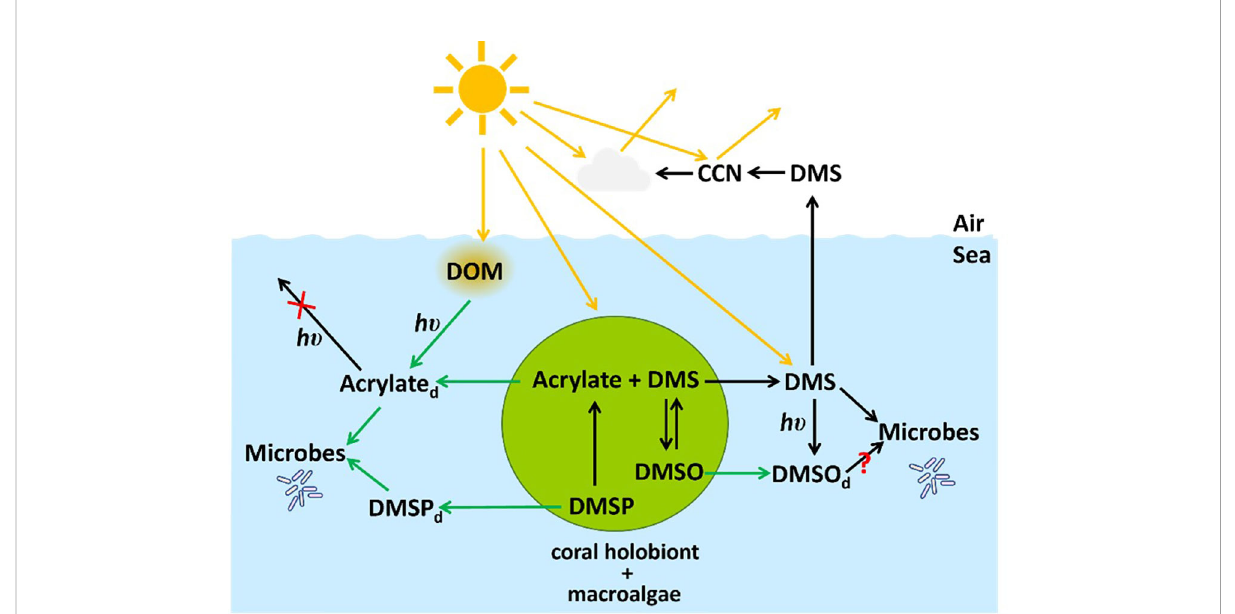
FIGURE 11 A simpli fi ed view of the marine organosulfur cycle (1) showing the link between the marine cycle and the atmosphere through DMS and the production of cloud condensation nuclei (CCN), and (2) depicting the main fi ndings of our study highlighted by green arrows. Dissolved acrylate is photochemically produced from the interaction of sunlight ( h υ ) with dissolved organic matter (DOM), and macroalgae and the coral holobiont release acrylate and DMSP into the dissolved phase where they are rapidly consumed by microbes in the Mo ’ orea coral reef. Acrylate does not photolyze in seawater at ambient concentrations including seawater from the Mo ’ orea coral reef (Xue and Kieber, 2021) as denoted with a red X. Macroalgae and A. pulchra are important sources of dissolved acrylate, DMSP and DMSO. The microbial consumption of DMSO is the presumptive main loss, but this was not con fi rmed in our study as indicated by the red question